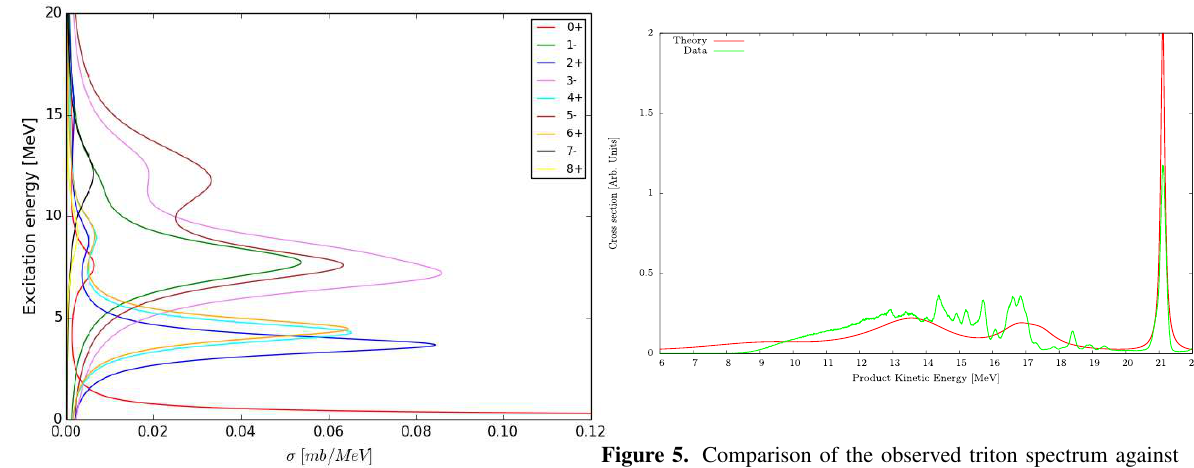
Figure 5. Comparison of the observed triton spectrum against the theoretical predictions integrated over the entire detector sur-